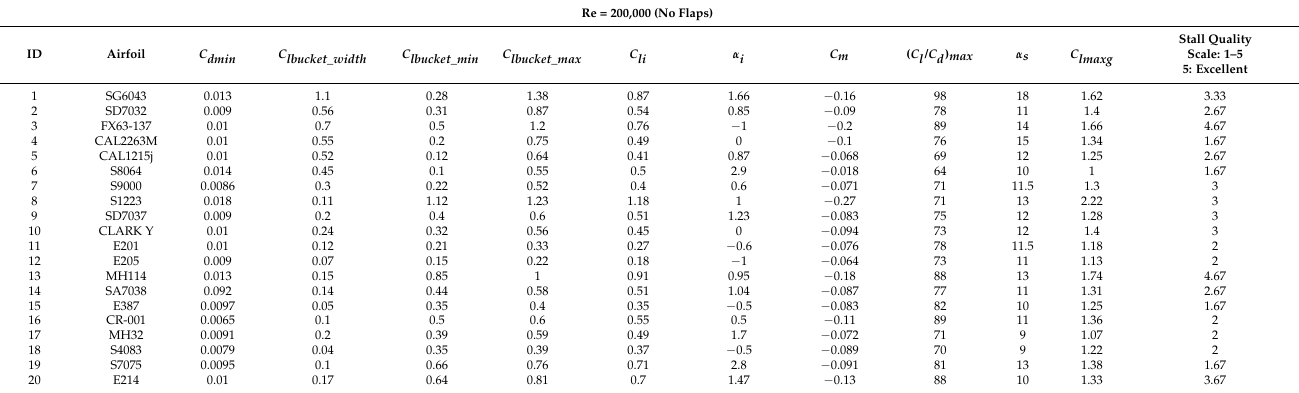
Table 7. Measurements of interest at Re = 200,000 and no flap